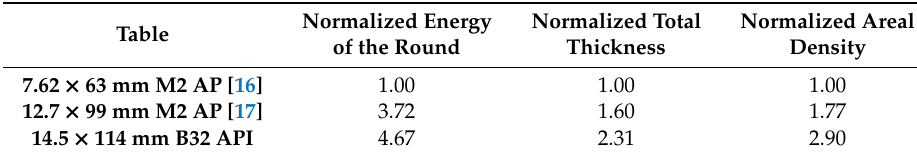
Table 4. Properties of CMF armors against the 12.7 mm and 14.5 mm AP threats when normalized by the average values of the 7.62 mm AP armors [16,17].